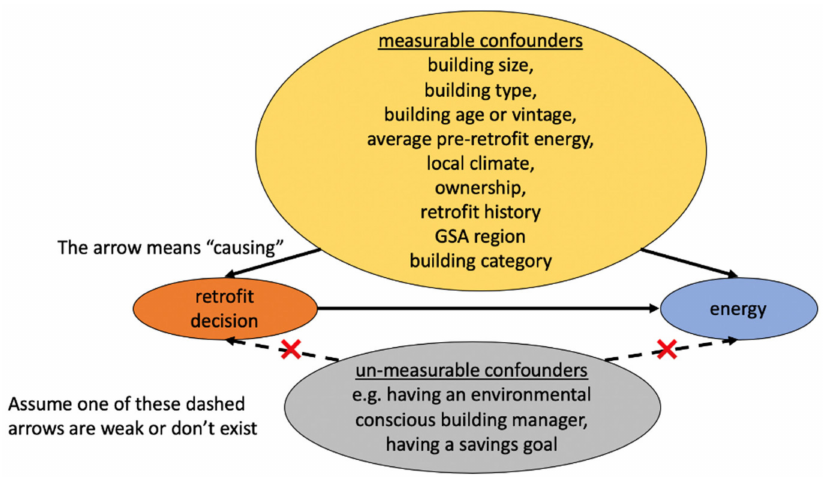
Figure 5. Simplified causal diagram. Table 4. The classification of retrofit effect